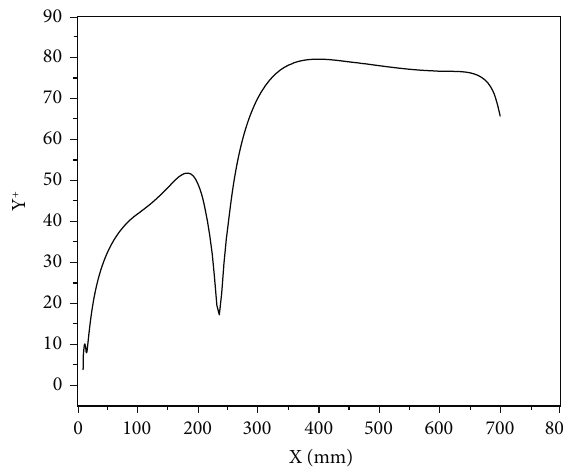
Figure 4: y + of case 2 with a grid number of 1.2